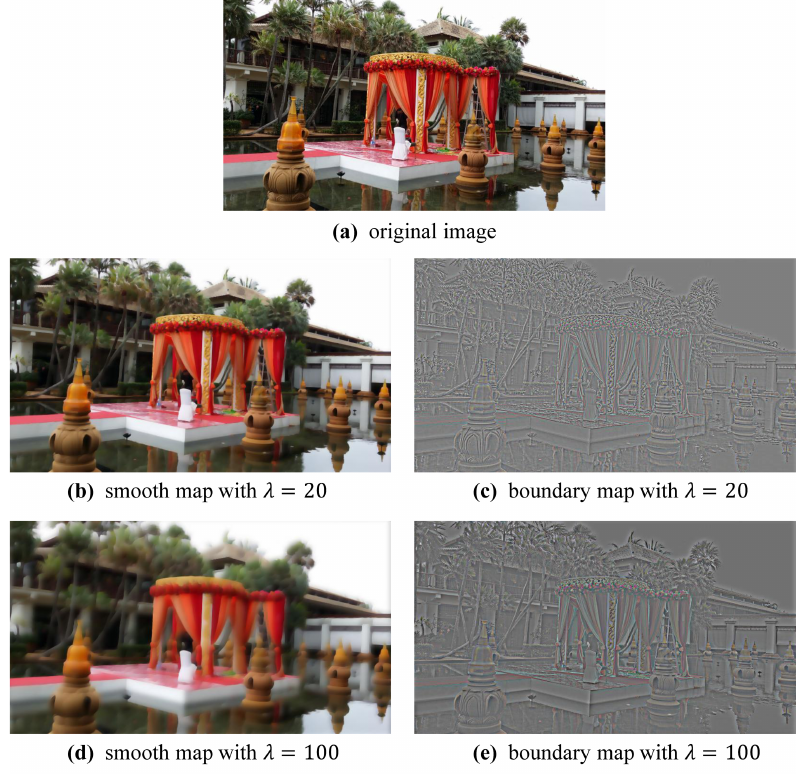
Figure 3. The smooth and boundary maps obtained from the original image with λ = 20 and